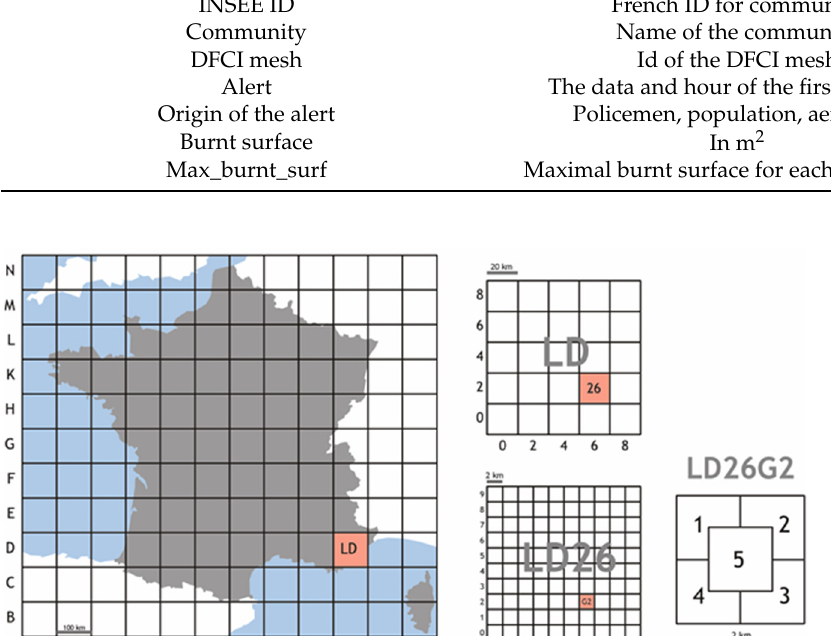
Figure 2. DFCI mesh, from the national to the local scale (https://www.data.gouv.fr/fr/datasets/carroyage-dfci-2-km/, (accessed on 12 October 2020)). The mesh has a value of 100 km with a letter code, exemplified with “LD”. Then, for the 20 km resolution, two figures are added—e.g., “LD26”—and for the 2 km a letter and a figure are added—e.g., “LD26G2”—providing a unique code for each mesh.